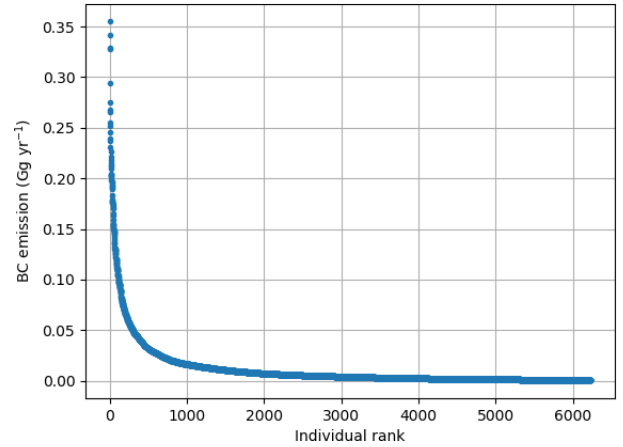
Figure 14. Flaring BC emissions (best estimate, Ggyr − 1 ) for each individual flaring location (6232 in total).